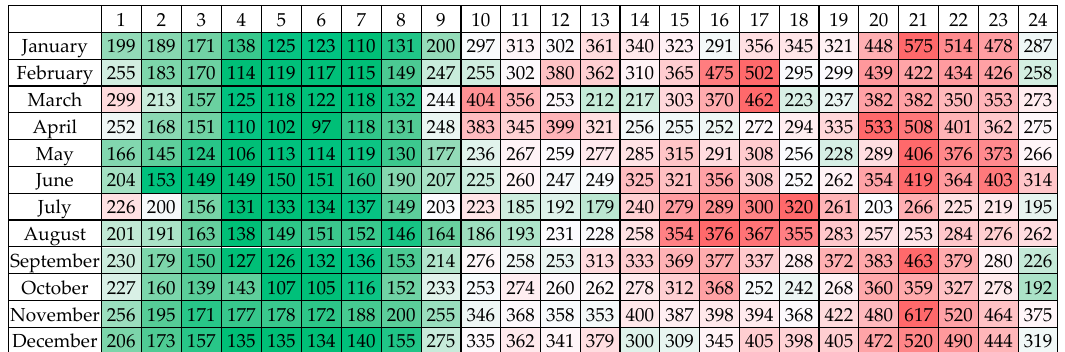
Figure 12. The aggregate profile of average power: non-working days. (Green: low; White: medium; Red: